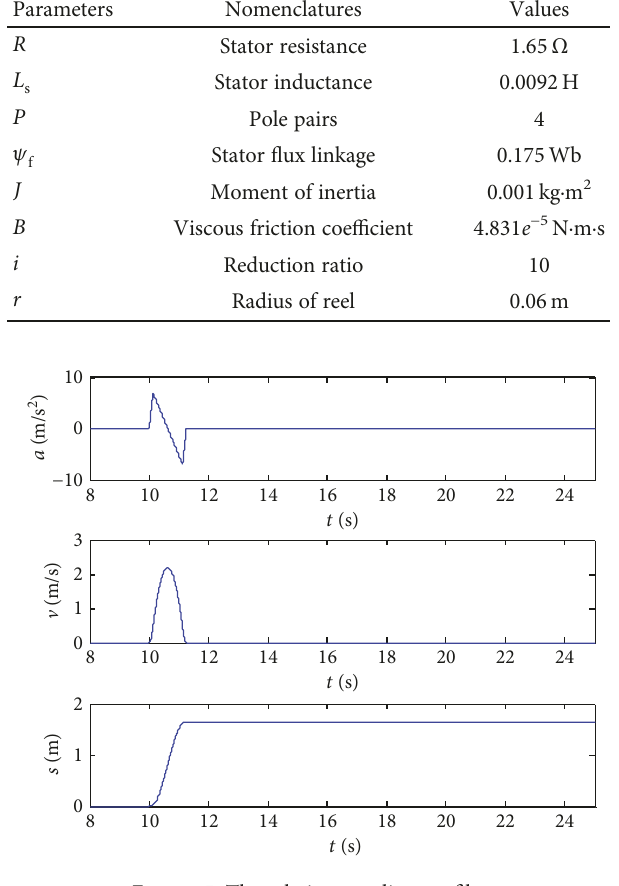
Figure 5: The relative coupling pro fi